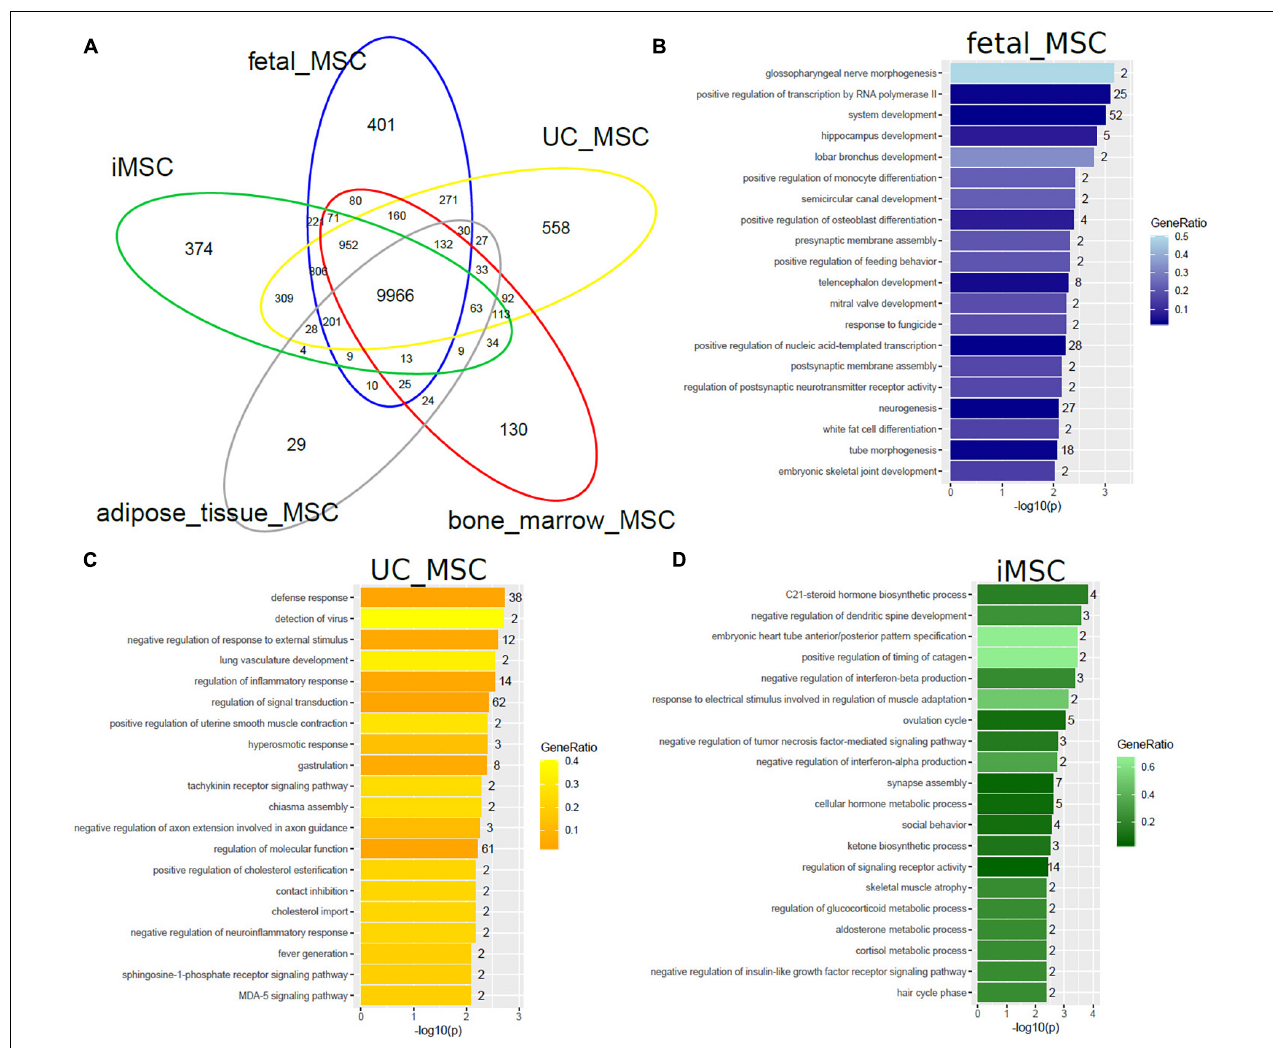
FIGURE 2 | MSCs of distinct origin share a large common gene signature but differ in smaller specific gene signatures. (A) The Venn diagram comparing gene expression in five MSC datasets on the Illumina Human HT-12 platform shows that most (9966) genes are expressed (detection- p -value < 0.05) in common. Specific to distinct types are subsets containing smaller numbers of genes: fetal MSCs-401, iMSCs-374, adipose-tissue-MSCs-29, bone-marrow-MSCs-130, and UC-MSCs-558. Over-representation analysis of Gene ontologies (GOs) in the specific subsets revealed GO terms of which the 20 most significant are listed here. (B) Significant GO terms in fetal MSCs relate to developmental and morphogenetic processes. (C) Significant GO terms in UC-MSCs relate to defense/inflammatory response, lung development, gastrulation. (D) Significant GO terms in iMSCs relate to hormone metabolism, neuronal development, interferon, and TNF